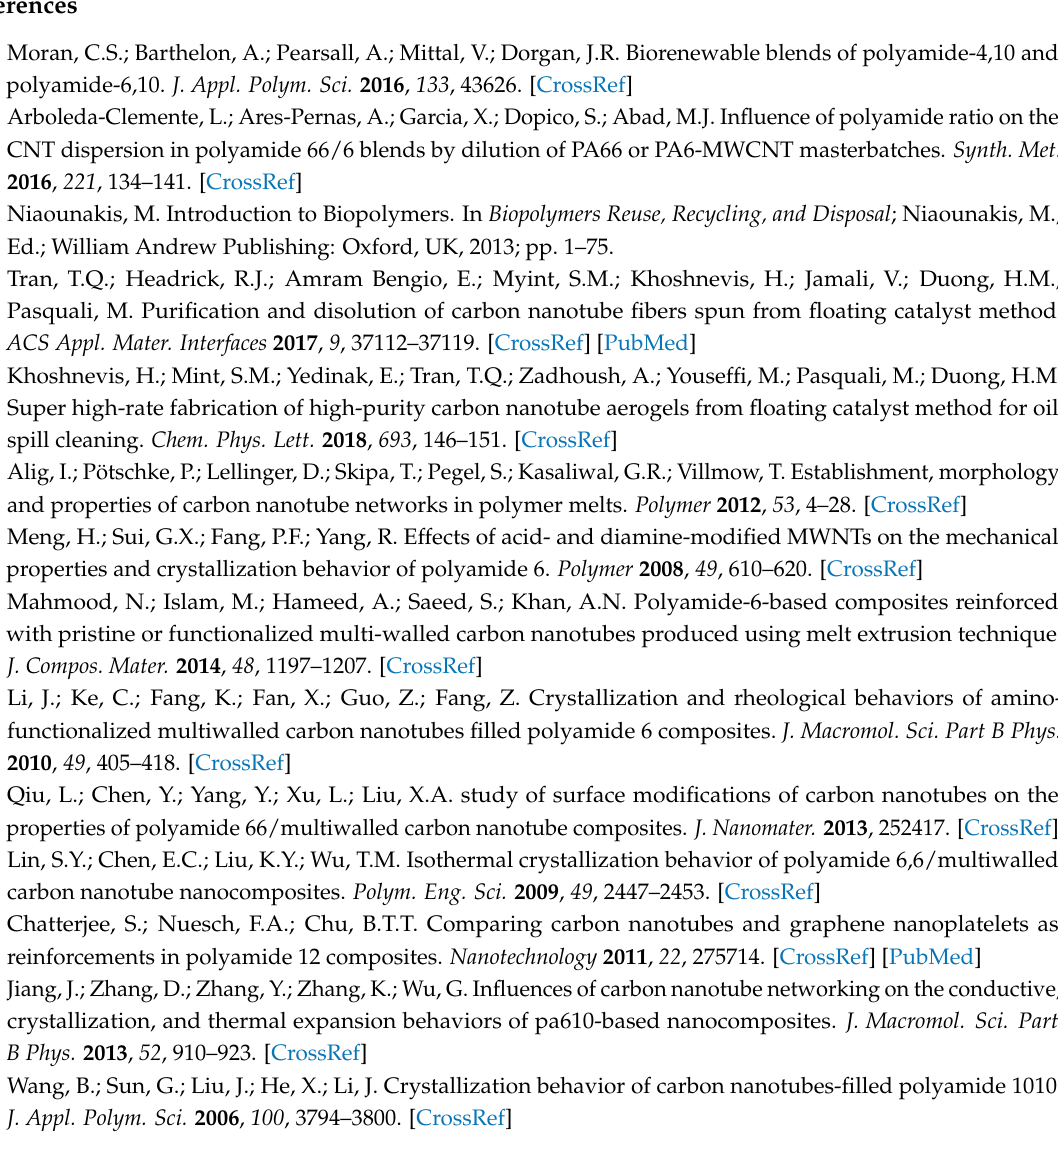
Figure S1: Normalized experimental melting DSC curves of PA6 and PA6/CNT masterbatch, Table S1: Calorimetric parameters of PA6 vs. PA/CNT